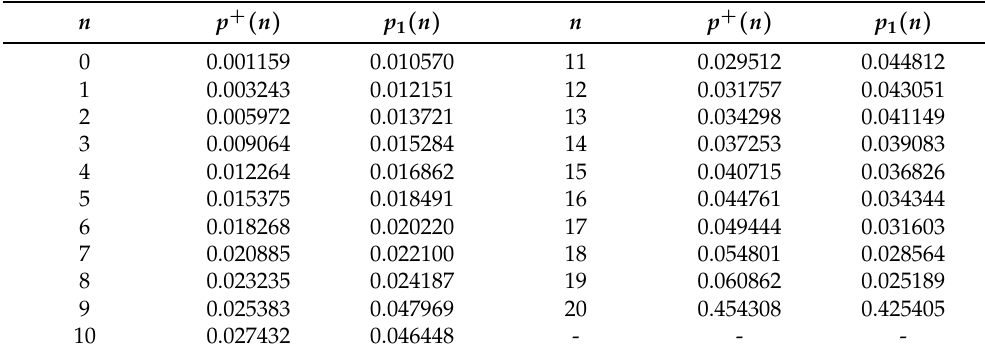
Table 3. Computation of post-departure epoch probabilities and arbitrary epoch probabilities (when the server is busy) for Example 3 with the parameters λ = 17.1525, µ = 0.95291, a = 4, b = 11, N = 20 and ρ = 1.636364.